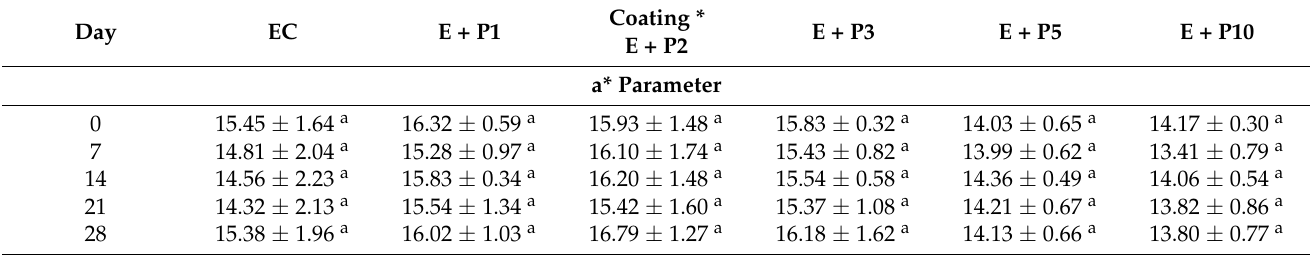
Table 2. Changes in a* parameter of the color of hen eggs coated with propolis extract at concentra- tions of 1, 2, 3, 5 and 10% during 28 storage days.